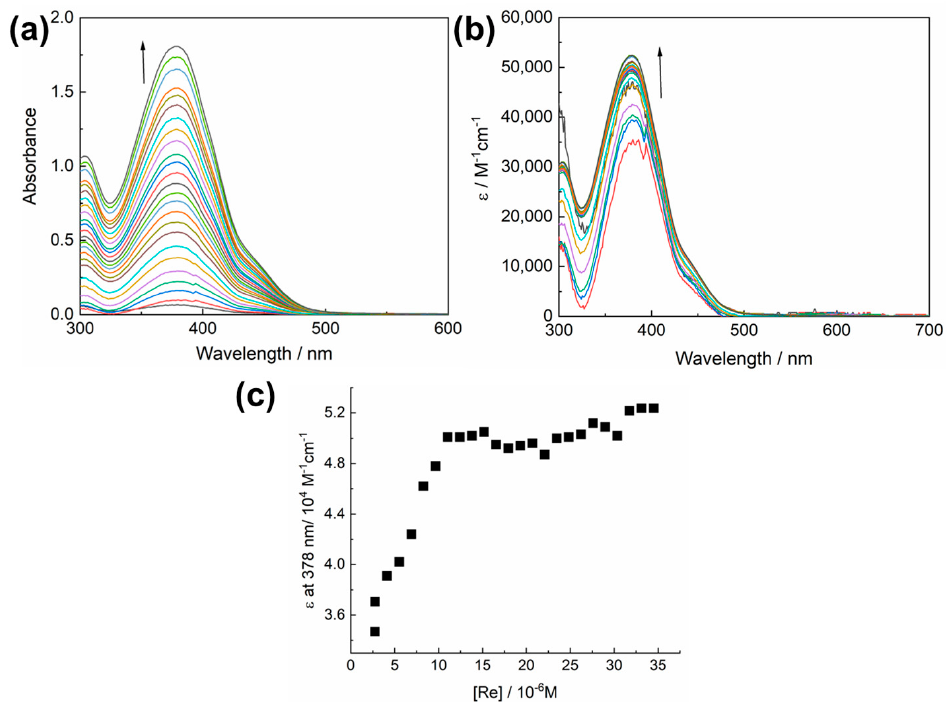
Figure 2. UV-vis absorption spectra displayed by plotting absorbance vs. wavelength ( a ) and apparent molar extinction coefficient ε vs. wavelength ( b ) for [Re(CO) 3 Cl(L)] DCM solutions with concentrations from 1.38 to 34.5 μ M. Arrows indicate the spectral and ε changes upon increasing concentrations. ( c ) A plot of ε at 378 nm vs. the concentrations.